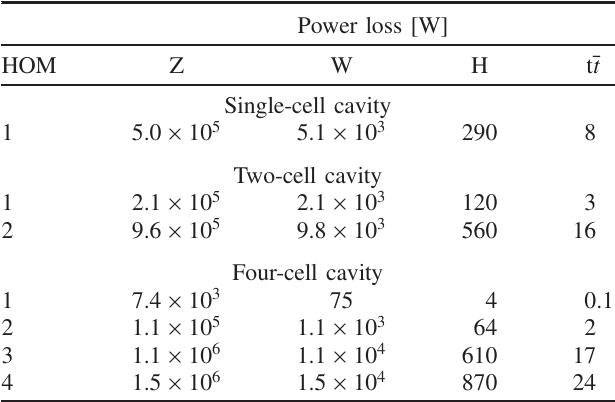
TABLE V. The worst-case scenario (HOM coincides with the bunch spacing spectral line) for the power loss due to HOMs. Calculations are done for the HOM parameters given in Table III assuming of Q ¼ 10 4